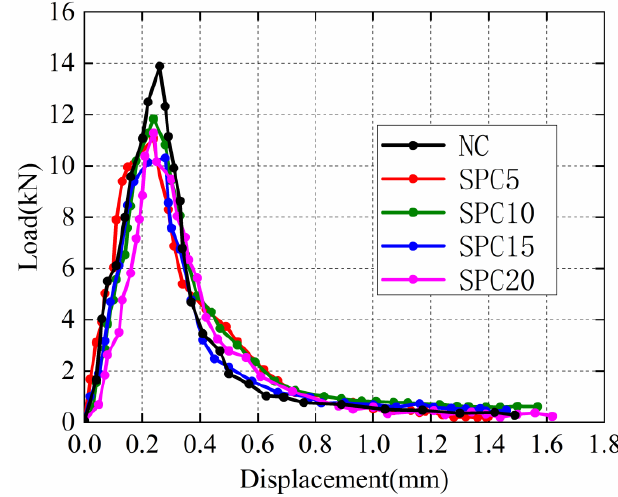
Table 3. Values of fracture energy of concrete of SFC.